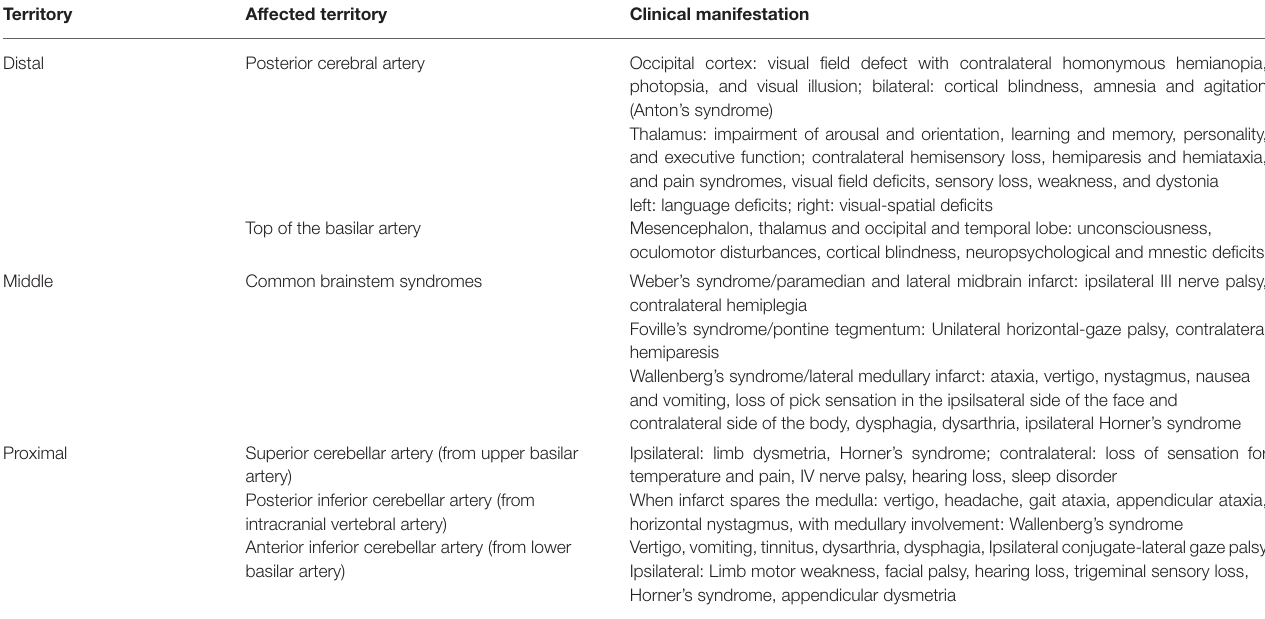
TABLE 1 | Clinical manifestations of posterior circulation stroke.